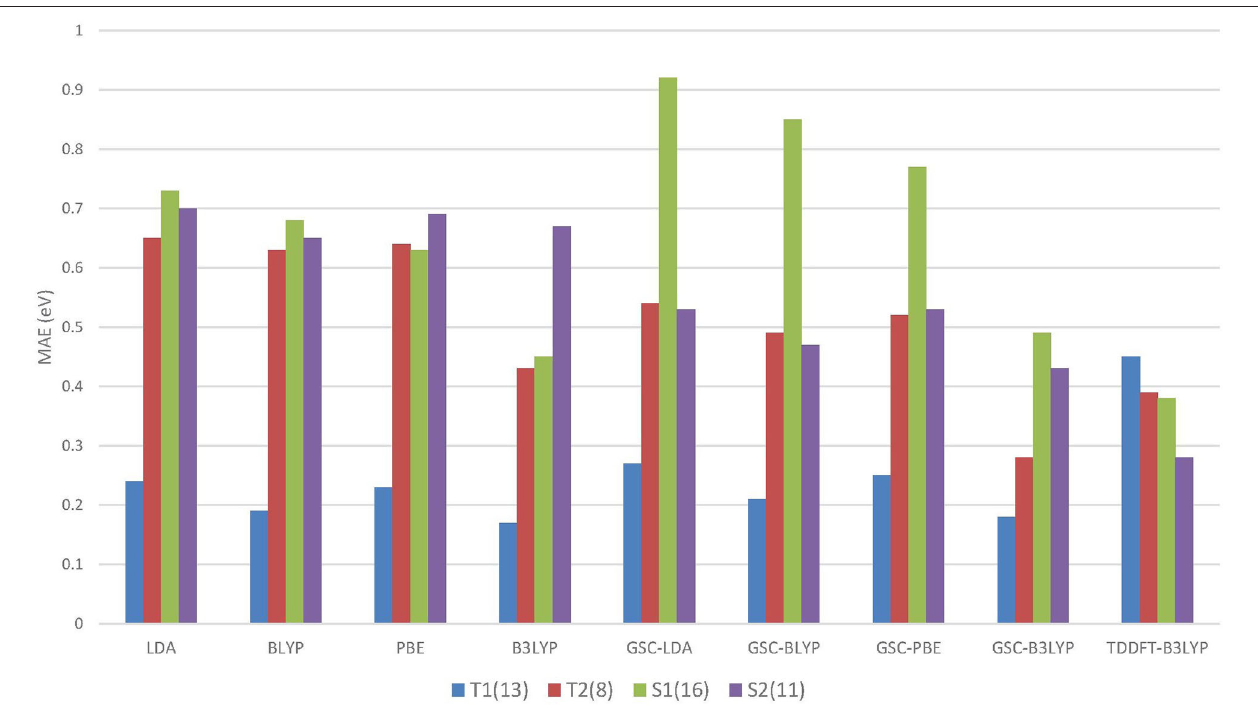
FIGURE 4 | The mean absolute errors (MAEs) of the energies of different types of excitations calculated by using the QE-DFT method with various density functional approximations (DFAs) and the basis set 6-311++G(3df, 3pd). For comparison purpose, the MAEs of the TDDFT-B3LYP results extracted from Mei et al. (2019) are also displayed. Excitation energies calculated by high-level wavefunction methods are used as the reference data (Schreiber et al., 2008). T1 and S1 (T2 and S2) refer to the triplet and singlet HOMO to LUMO (LUMO+1) excitations, respectively. The numbers in the parentheses record the numbers of energy data belonging to the different types of